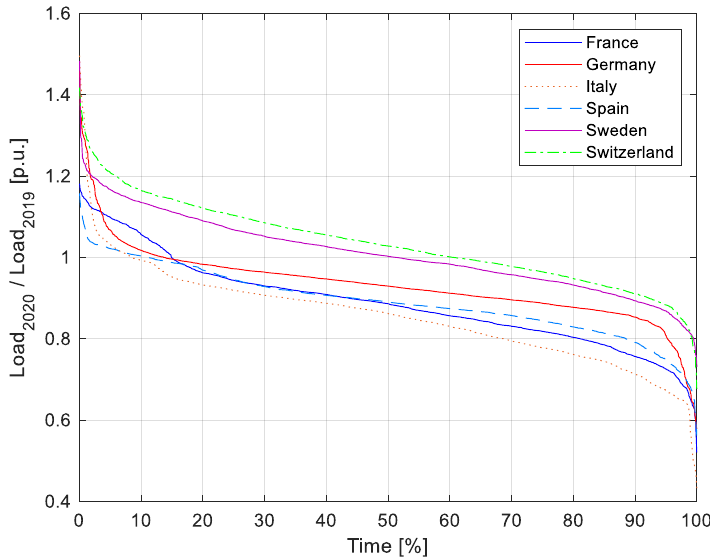
Figure 4. Duration curve of the ratio between the 2020 and 2019 power demand for a selected number of countries.